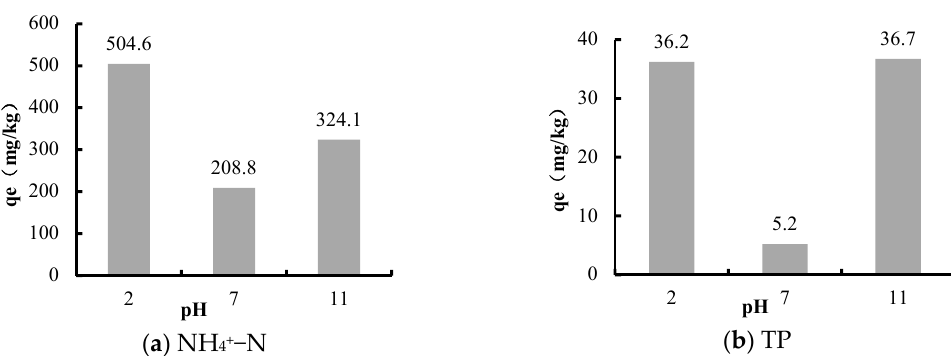
+ –N and TP in Biliuhe 4